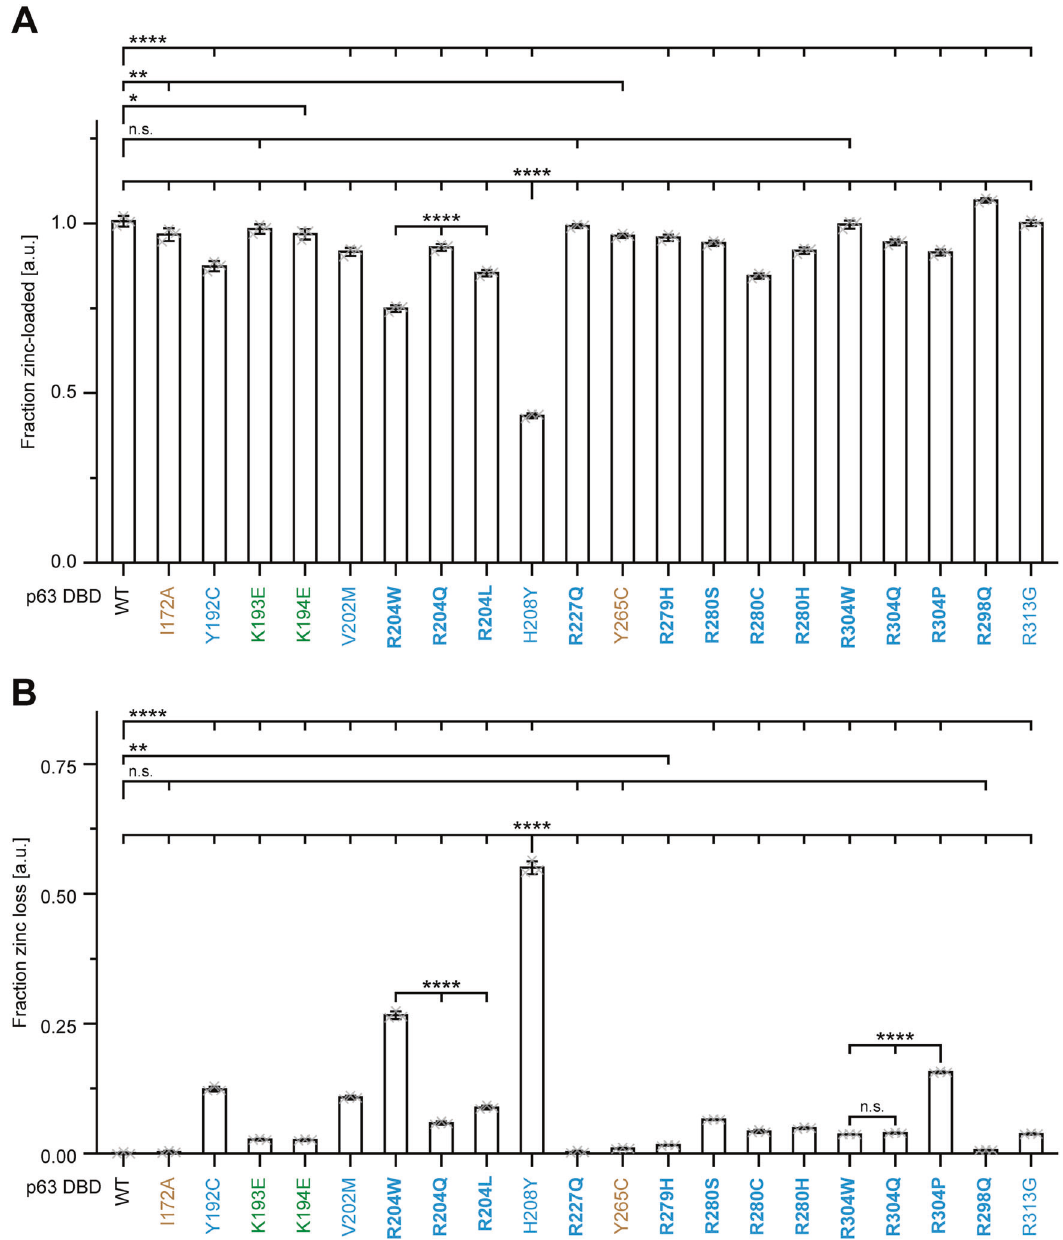
Fig. 3 A subgroup of p63 DBD mutations destabilize the structurally important zinc fi nger. A Zinc content assay of the puri fi ed p63 WT and mutant DBDs. Bound zinc was released from the DBD zinc fi nger by an alkylation agent and the concentration was determined by a colorimetric analysis using the zinc binding dye PAR. The zinc concentration was referenced to the protein concentration. The bar diagram shows the mean fraction of DBDs in the holo form and error bars the corresponding SD ( n = 3). B Zinc dissociation assay of the puri fi ed p63 WT and mutant DBDs. Release of the zinc ion from the zinc fi nger during incubation at 37 °C in presence of the PAR was measured via the speci fi c absorbance of the PAR 2 -Zn 2 + complex. In a second reaction the total zinc content was determined by complete release of the bound zinc with an alkylating agent. The DBD and PAR concentrations were 30 µM and 500 µM, respectively. The bar diagram shows the mean fraction of zinc dissociated in relation to the total zinc content and error bars the corresponding SD ( n = 3). A , B Statistical signi fi cance was assessed by ordinary one-way ANOVA followed by Tukey ’ s post hoc test (Supplementary Table S3). n.s. P > 0.05, * P ≤ 0.05, ** P ≤ 0.01, *** P ≤ 0.001, **** P ≤ 0.0001. Mutations related to ELA syndrome are coloured in blue, mutations related to SHFM4 in green and arti fi cial mutants in brown. Hotspot mutations are highlighted in Δ Np63 α WT (Fig. 6D + E). Consistent with previous reports [34 – 36] regions (Fig. 6C), suggesting that the presence of p63 affected and with the ATAC-seq data, almost 80% of the p63 binding sites mainly chromatin conformation of the distal regions. were located at non-promoter regions (Fig. 6E), indicating that p63 To determine the ability of WT and mutant p63 to associate is primarily involved in gene regulation through distal cis- with chromatin, ChIP-seq with anti-p63 antibodies was performed. regulatory regions. Integration with ATAC-seq data revealed that ~26000 p63 binding sites were identi fi ed in cells expressing